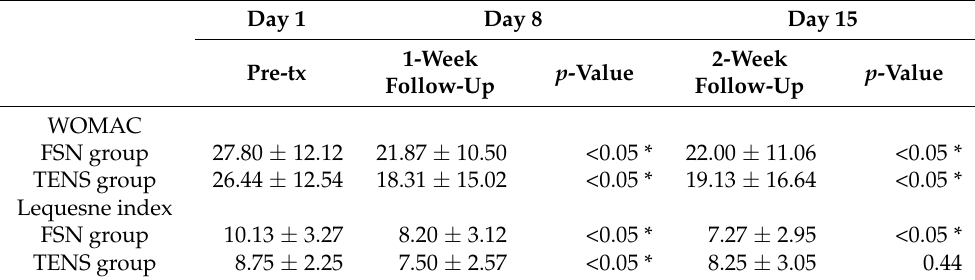
Data are expressed as the mean ± SD; * indicates a significant difference, analyzed by a paired t-test. Abbreviations: FNS, Fu’s subcutaneous needling; TENS, transcutaneous electrical nerve stimula- tion; WOMAC, Western Ontario and McMaster Universities. Table 4. WOMAC and Lequesne indices compared between the FSN and TENS groups. Day 1 Day 8 Day 15 1-Week p -Value p -Value Pre-tx Follow-Up Follow-Up